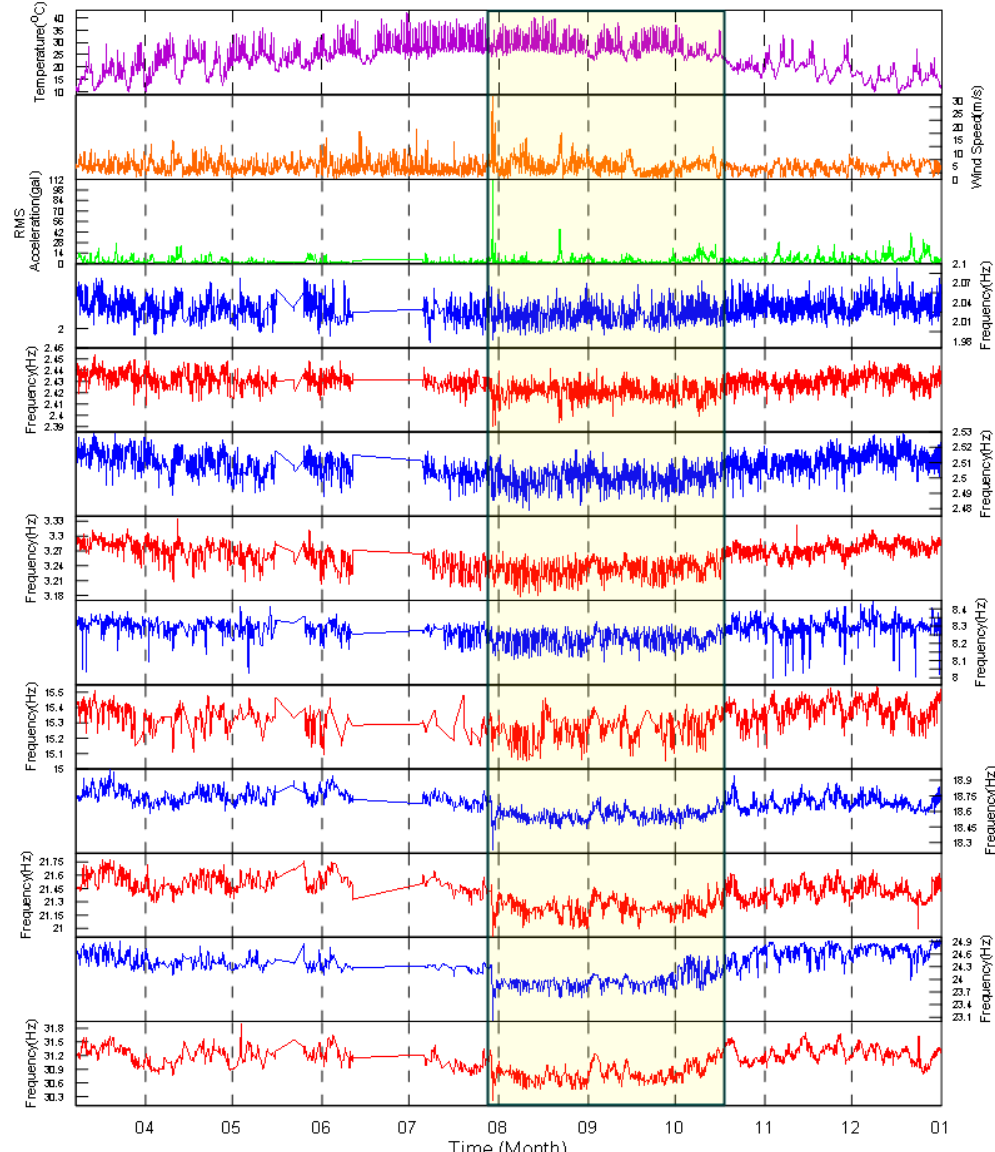
Figure 13. Comparison of identified modal frequencies while considering three different environmental factors in 2017. The middle section with a yellow background represents the phase II.